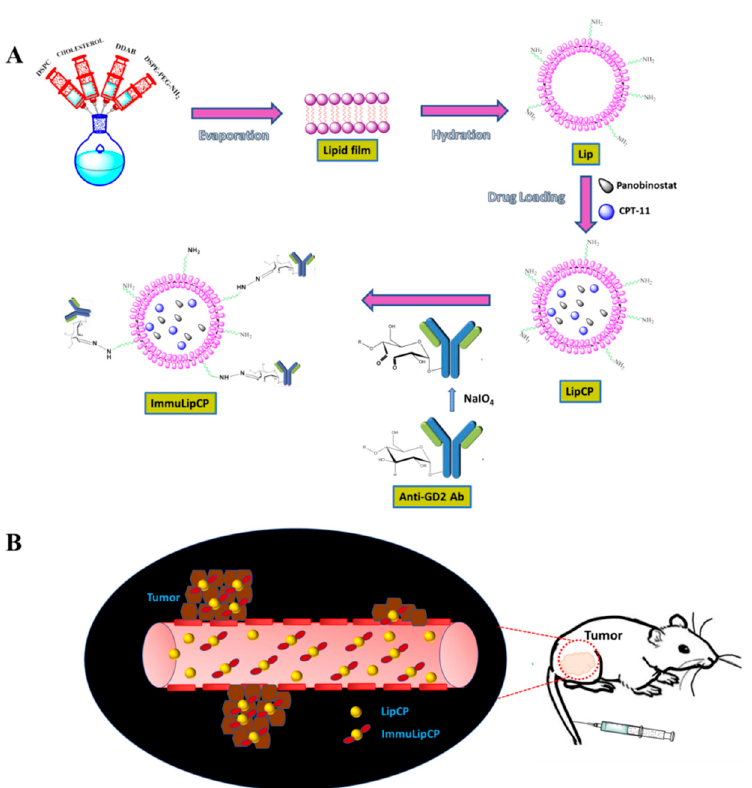
Figure 1. ( A ) The liposomes (Lip) were formed from 1,2-distearoyl-sn-glycero-3-phosphocholine (DSPC), dimethyldioctadecylammonium bromide (DDAB), cholesterol and N-(aminopropyl polyethyleneglycol)carbamyl-distearoylphosphatidyl-ethanolamine (DSPE-PEG-NH 2 ) using the thin film hydration method. The drugs were loaded into liposomes by repeated freeze-thaw cycles to prepare CPT-11 and panobinostat-loaded liposomes (LipCP). The LipCP was surface conjugated with anti-GD2 Ab by forming covalent bonds between surface amine groups in liposomes and aldehyde groups in activated anti-GD2 Ab that is formed after NaIO 4 -catalyzed ring opening of the sugar moiety in the Ab. ( B ) The ImmuLipCP could show enhanced cytotoxicity toward tumor cells overexpressing GD2 over LipCP.